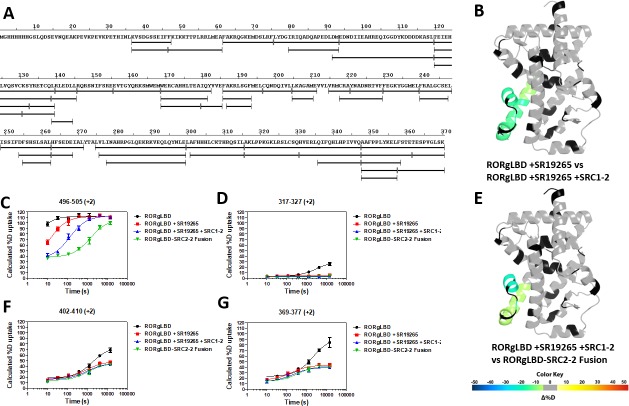
Overview of HDX-MS characterization of RORγ (related to Figures 1–5).(A) Sequence coverage map of peptic RORγLBD peptides. The sequence of the HisSUMO-RORγLBD construct is shown above and observed peptides are shown as black sticks. Selected deuterium build up curves of peptides from H12, H3, H7, and the BSR in panels C,D,F, and G, respectively. The numbering scheme for peptides is adjusted to match the sequence numbering of RORγ. (B and E) Selected differential HDX-MS experiments painted onto RORγLBD in the active conformation (PDB ID 3L0L). Differential of RORγLBD liganded with SR19254 ±SRC1-2 peptide is shown in B. The differential of RORγLBD + SR19265+SRC1-2 vs RORγLBD-SRC2 fusion is shown in E.